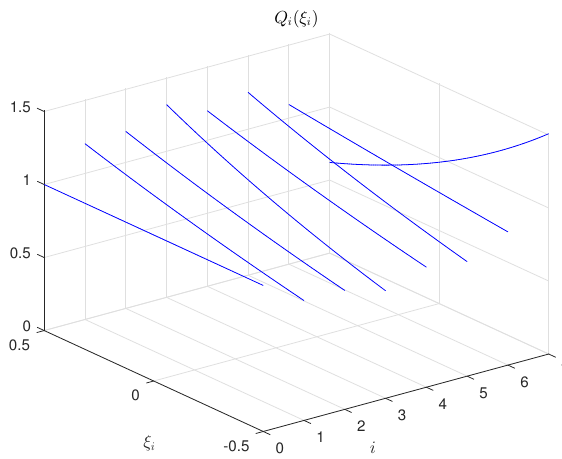
Figure 2. The family of the PDFs of the noise ξ i , i ∈ [ 0,7 ] .